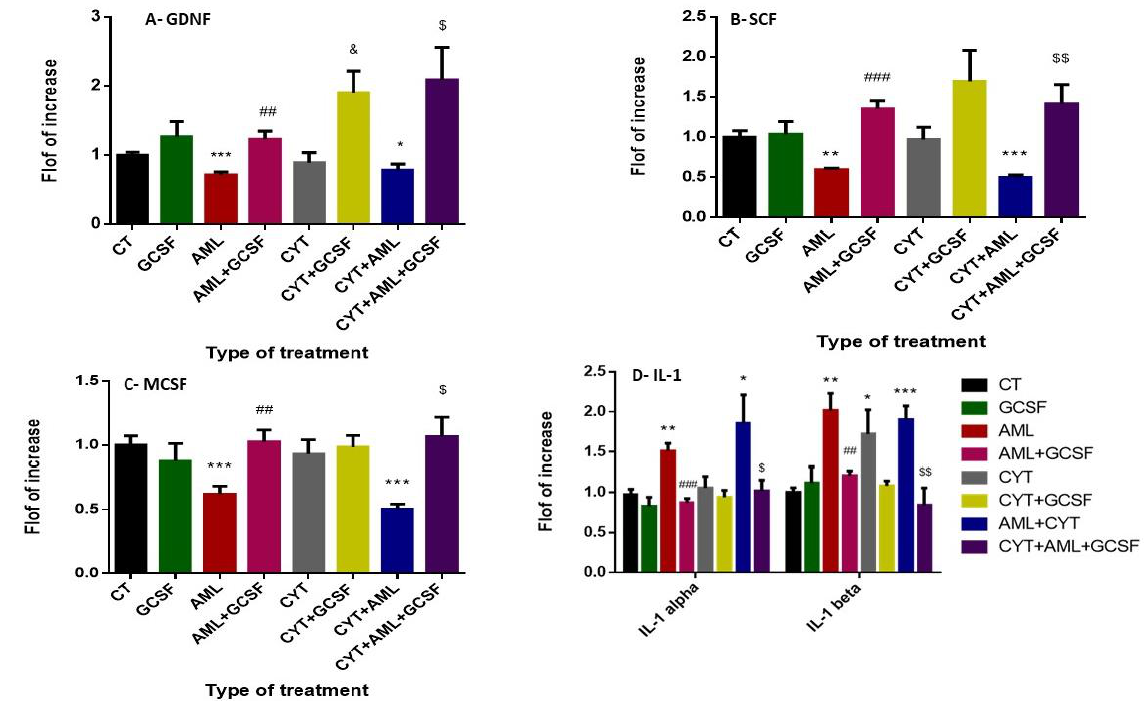
Figure 6. Effect of GCSF on the expression levels of testicular growth factors and pro-inflammatory cytokines of AML- and CYT-treated mice. Mice were treated as described in Figure 2. The RNA expression levels of the growth factors GDNF ( A ), SCF ( B ), MCSF ( C ) and the pro-inflammatory cytokines IL-1 alpha and IL-1 beta ( D ) in testes of all examined groups were tested by qPCR analysis using specific primers for each factor. qPCR results are presented as fold increase compared to the control group (CT). The results are representative of 3 independent experiments with 3 mice in each group per experiment. *—significant compared to control (CT). #—significant compared to AML, &—significant compared to CYT, $—significant compared to AML + CYT. %—significance of AML + CYT compared to CYT. *,#,&,$,%— p < 0.05; **,##,&&,$$— p <